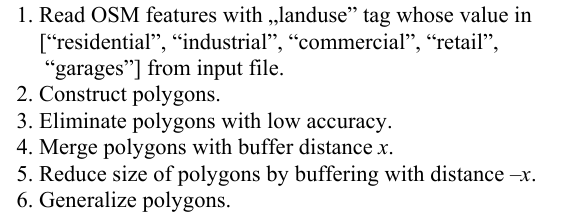
Figure 6. Algorithm 1 for processing OSM built-up